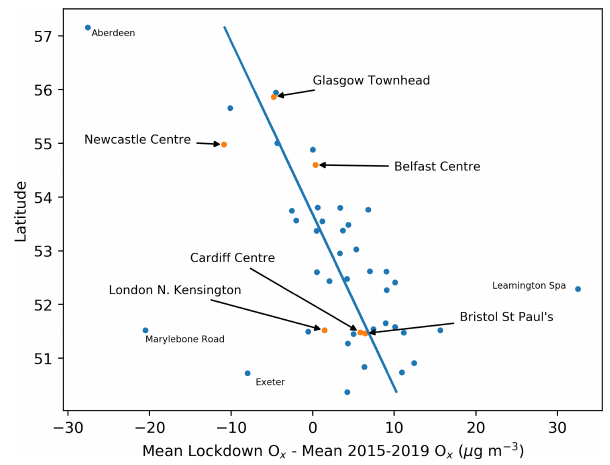
Figure 8. Difference in mean O x (µgm − 3 ) and between the lock- down period and the detrended mean of the same period from 2015 to 2019 for urban background sites as a function of latitude. Sites examined in Fig. 6 are highlighted in